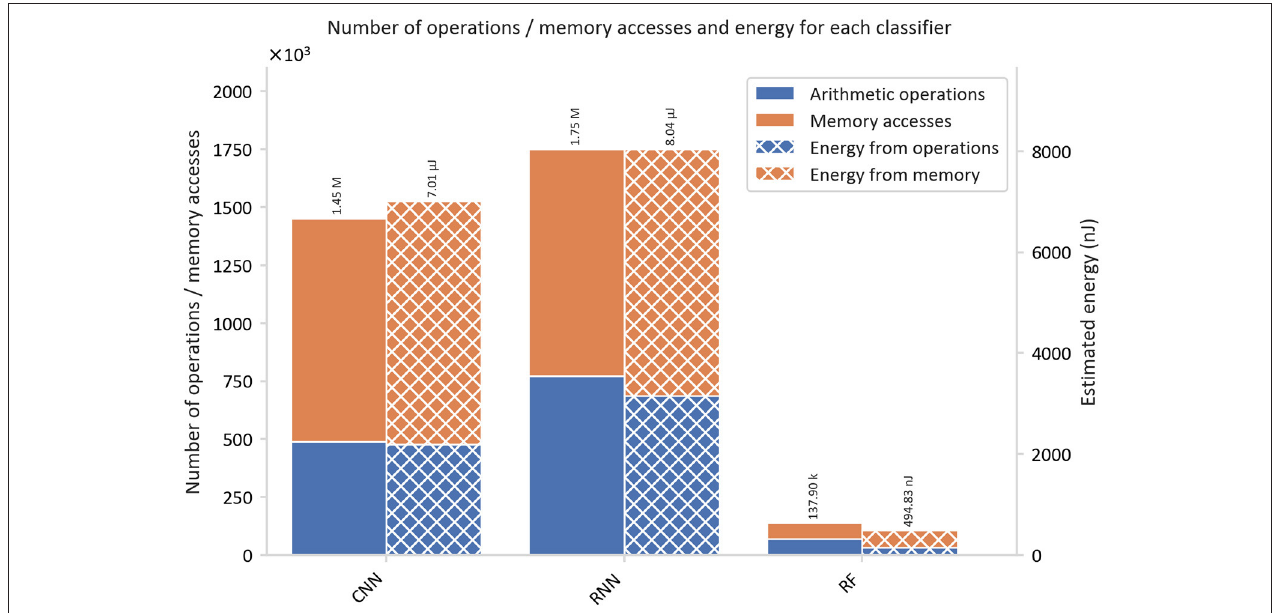
FIGURE 7 | Comparison of the classification energy consumption and the number of operations for the proposed seizure detection classifiers.